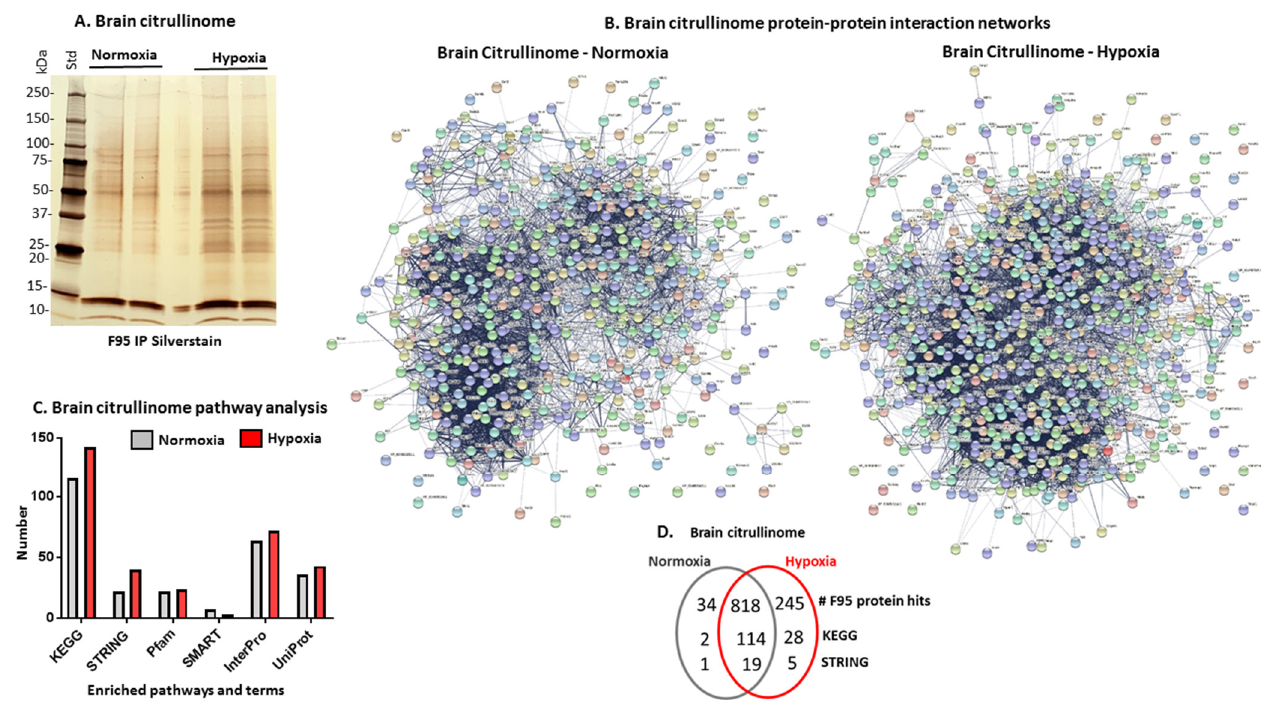
Figure 7. The brain citrullinome of naked mole-rats following normoxia or hypoxia treatment. ( A ) SilverGel showing F95-enriched proteins from control brains (normoxia) and brains taken from animals after a hypoxia challenge; n = 5 (pool of 5 brains per group; 2 experimental replicates). ( B ) Protein-interaction networks for all deiminated protein candidates identified in naked mole-rat brains following normoxia or hypoxia (brain citrullinome). ( C ) STRING pathway analysis results for KEGG and GO terms for the full brain citrullinome following normoxia or hypoxia treatment. ( D ) Venn diagram summarising deimination/citrullination hits (F95) and shared and specific pathways for the citrullinome between normoxic and hypoxic brains ( n = 5 brains per group in all experiments). Table 5. Local network cluster STRING networks for all F95-enriched proteins identified in naked mole-rat brains following normoxia and hypoxia treatment. A tick ( V ) indicates whether the pathway was identified in the respective group; normoxia-specific pathways are highlighted in blue and hypoxia-specific pathways in pink. A full list of the protein hits underlying the network analysis is provided for both groups in Supplementary Tables S1 and S2.